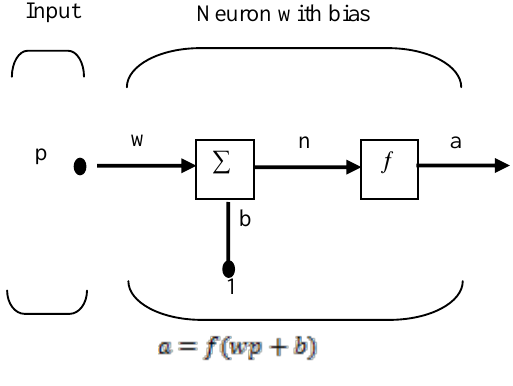
Fig. 3. Architecture of a simple